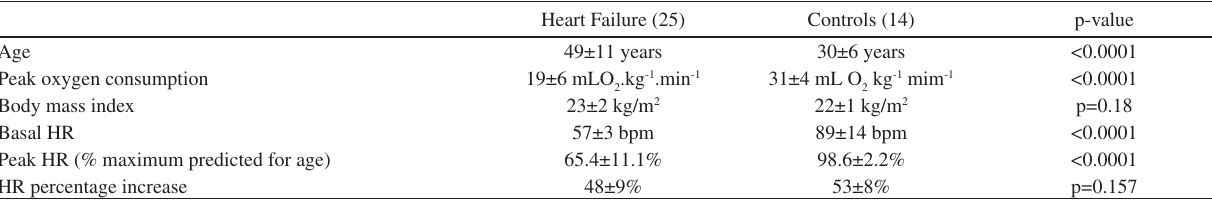
Table 1 - Subject characteristics